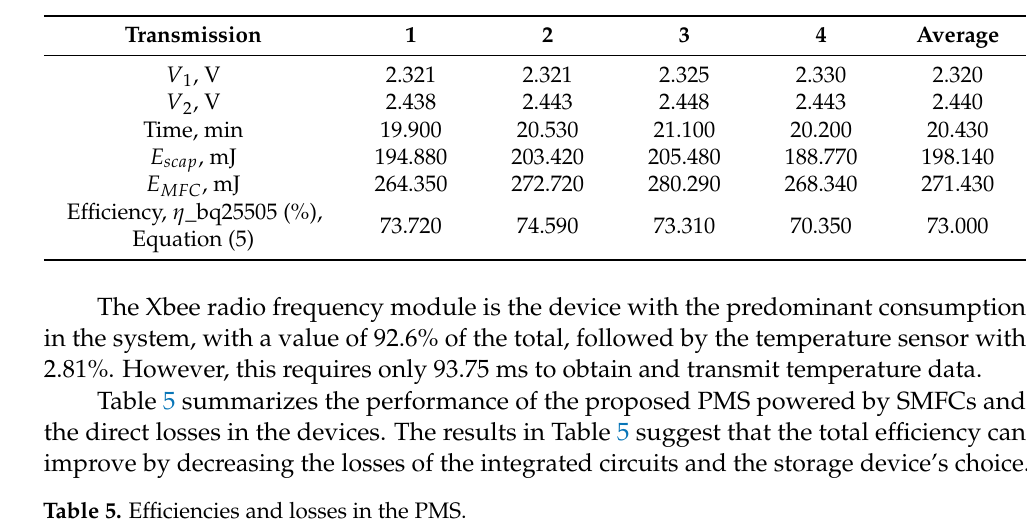
Table 4. Values of energy stored in each transmission period of the sensor node.